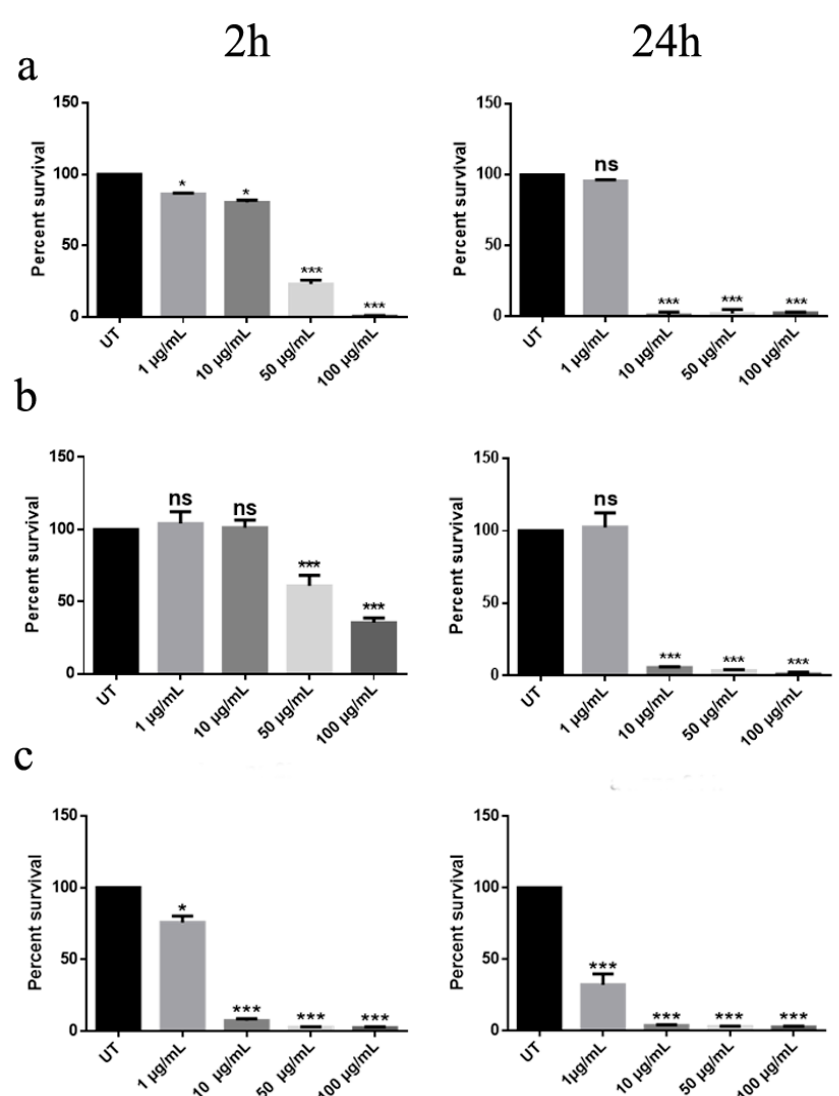
Figure 1. Effect of zinc oxide nanorods (ZnO-NRs) on different strains viability. Bacteria were treated not (UT: untreated) with di ff erent concentrations of nanorods for 2 h (left column) or 24 h (right column) or not (UT: untreated) with different concentrations of nanorods for 2 h (left column) or 24 h (right and bacterial survival was evaluated by CFU counting analysis. ( a – c ) indicate respectively A.